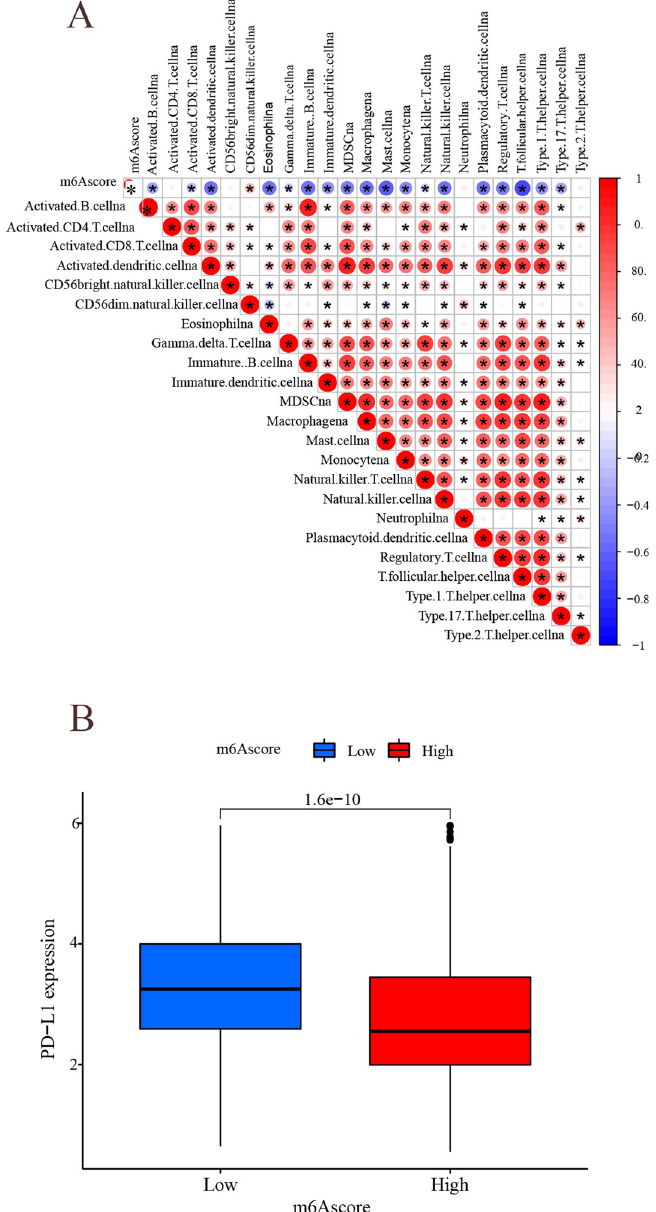
Fig 15. Analysis of immune˚immune correlation. (A) Immunocorrelation analysis. Horizontal and vertical coordinates indicate immune infiltrated cells and m 6 A score, while the intersecting circles indicate the correlation between them. Besides, red indicates positive correlation, and blue indicates a negative correlation. The darker the color, the larger the circle, and the closer the correlation. (B) The horizontal coordinate represents the m 6 A subgroup and the vertical coordinate represents PD-L1